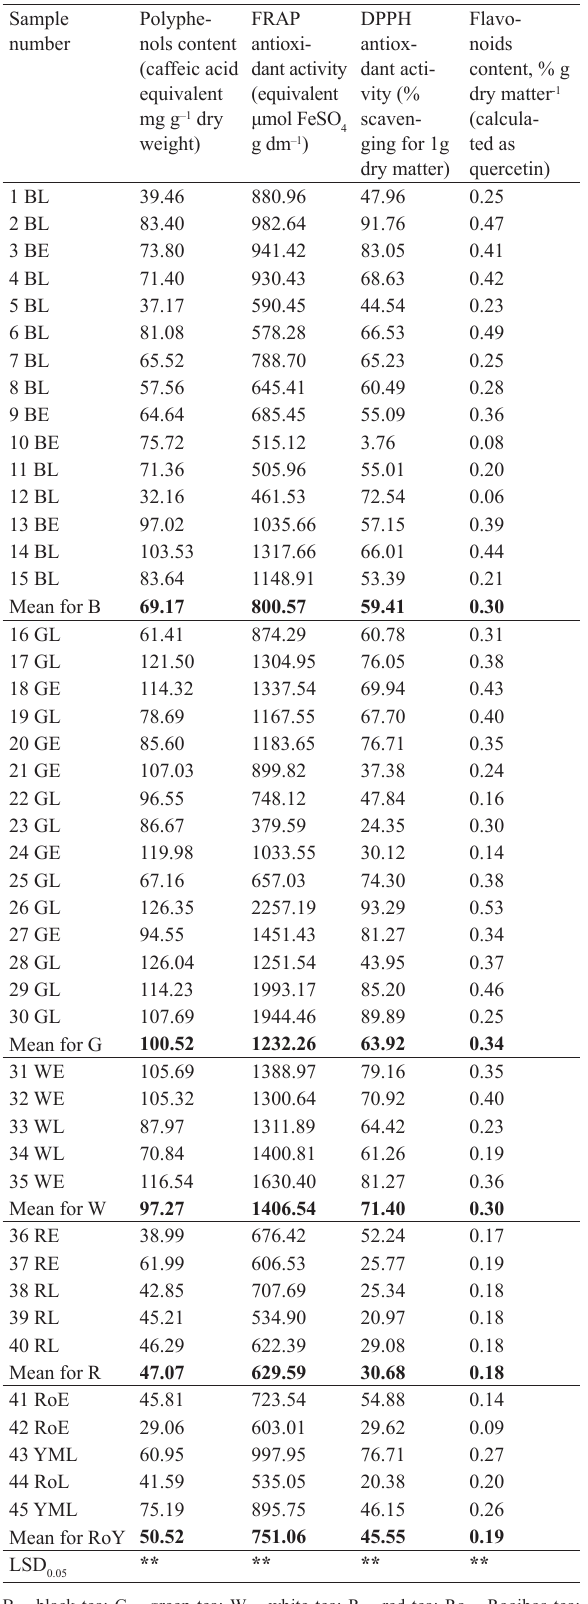
Table 1 Polyphenols content, flavonoids content, FRAP and DPPH antioxidant activity of tea after 10 min of brewing Sample